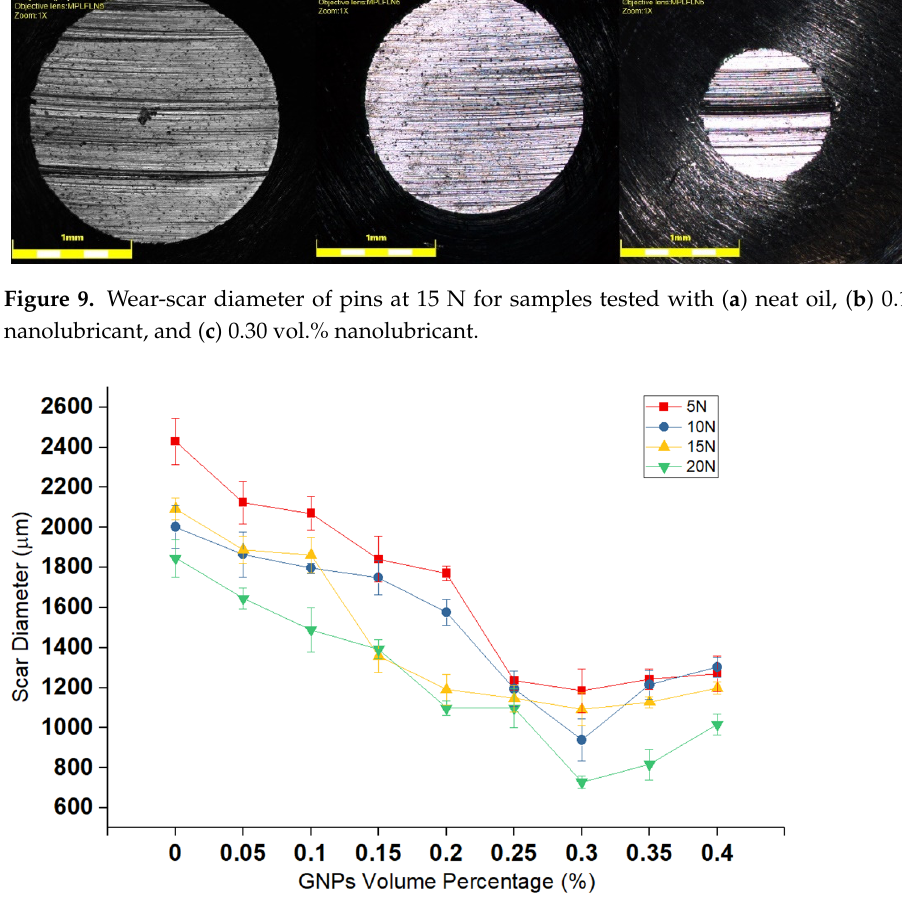
Figure 10. Correlation of wear-scar diameter pin with graphene volume percentage of nanolubricant at different applied loads.